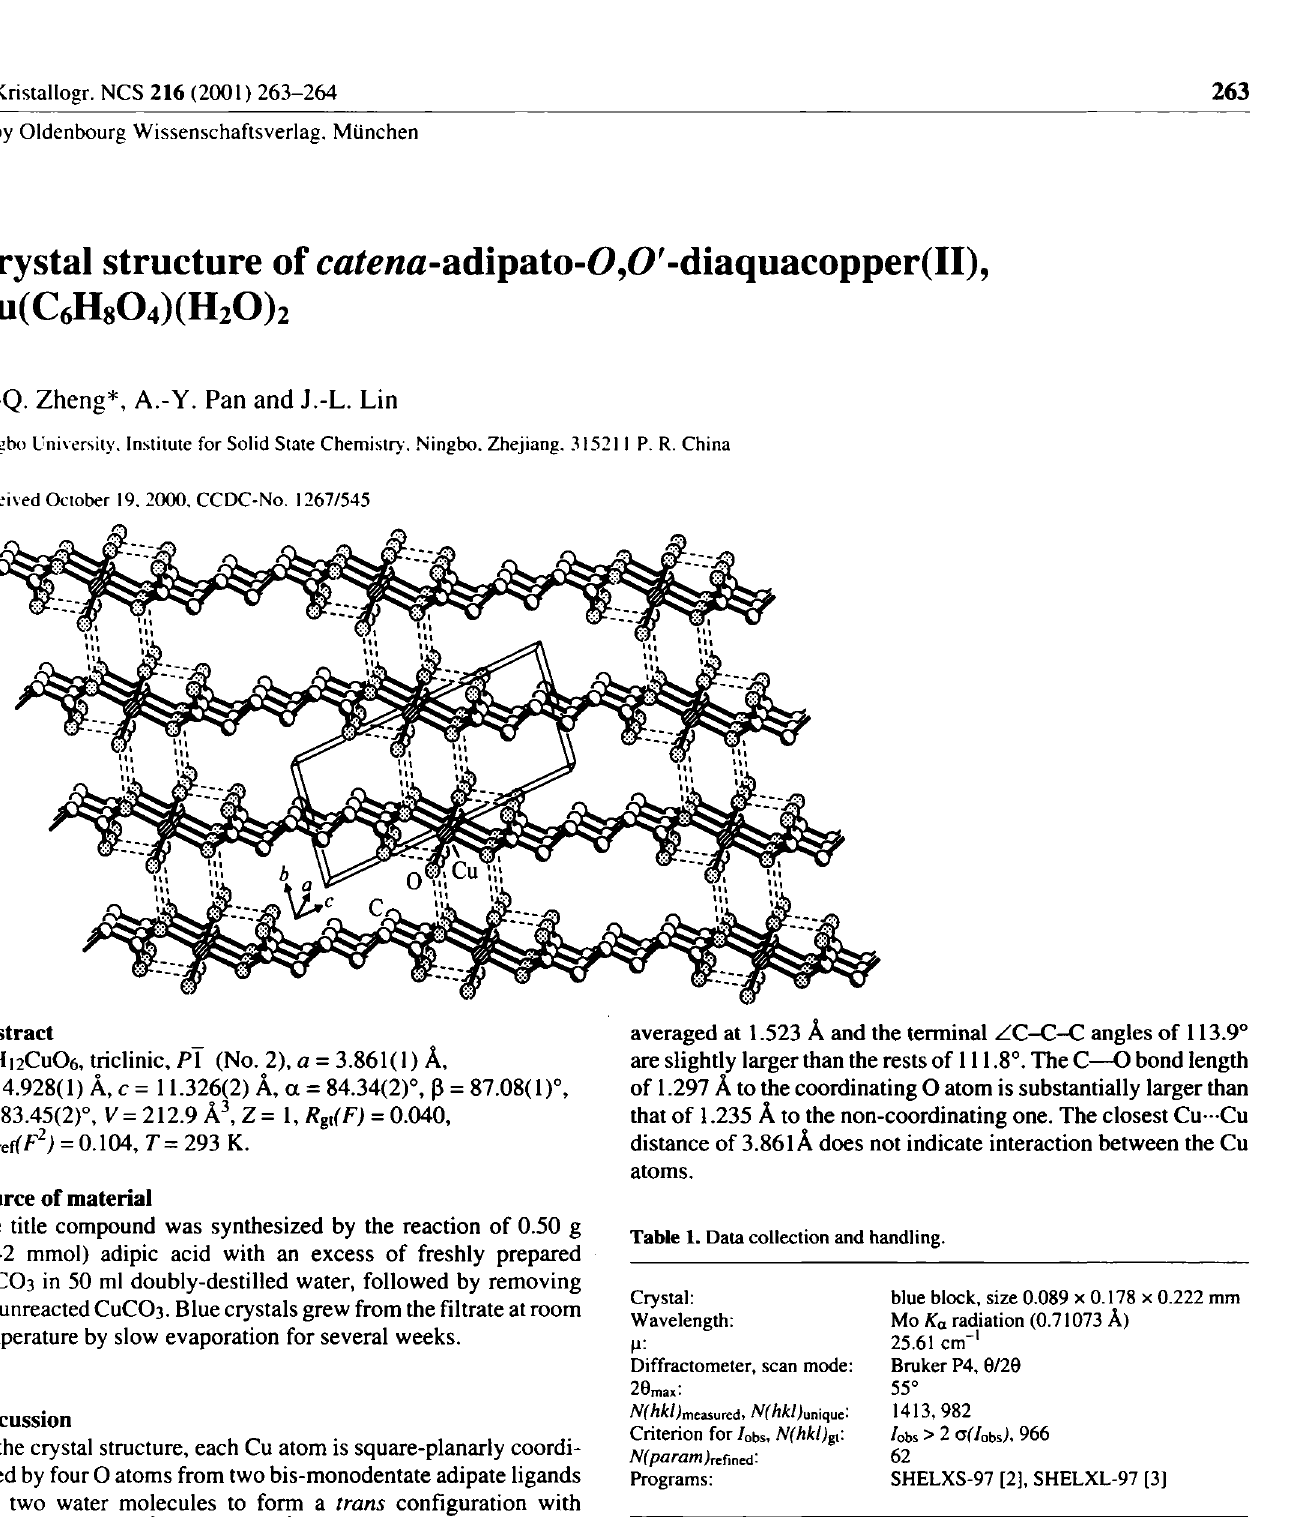
Table 2. Atomic coordinates and displacement parameters (in A 2